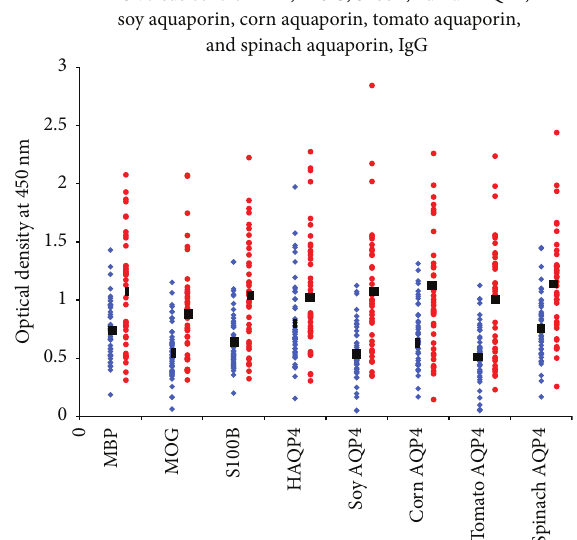
Figure 3: IgM antibody values of RRMS patients (blue diamond) versus controls (red circle): MBP, MOG, S100B, human AQP4, soy aquaporin, corn aquaporin, tomato aquaporin, and spinach aqua- porin. The levels of serum IgM antibodies against all tested antigens showed even more significant differences between the control and patient groups, with all eight antigens showing 𝑝 < 0.0001